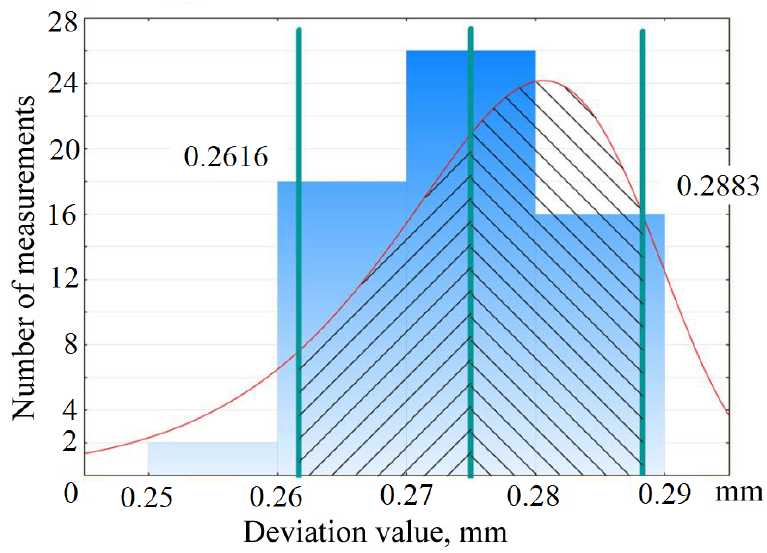
Figure 2. Diagram of deviation distribution of the root diameter of the cycloid profile within the tolerance zone, TD = 0.04 mm.